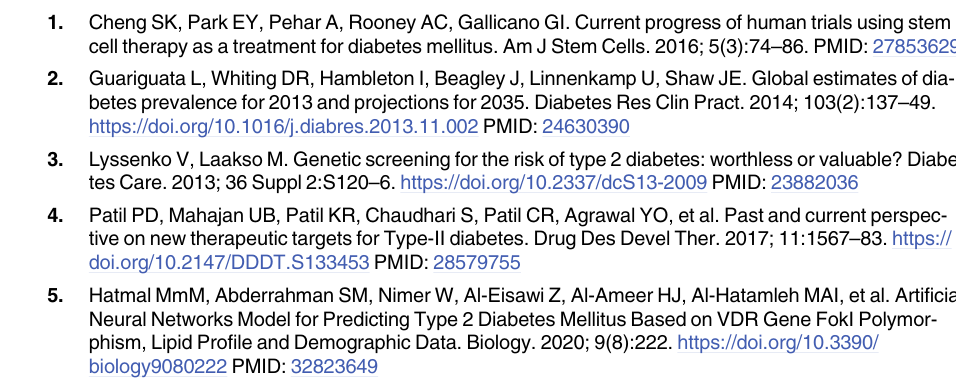
S11 Table. Meta-analysis of genetic association studies